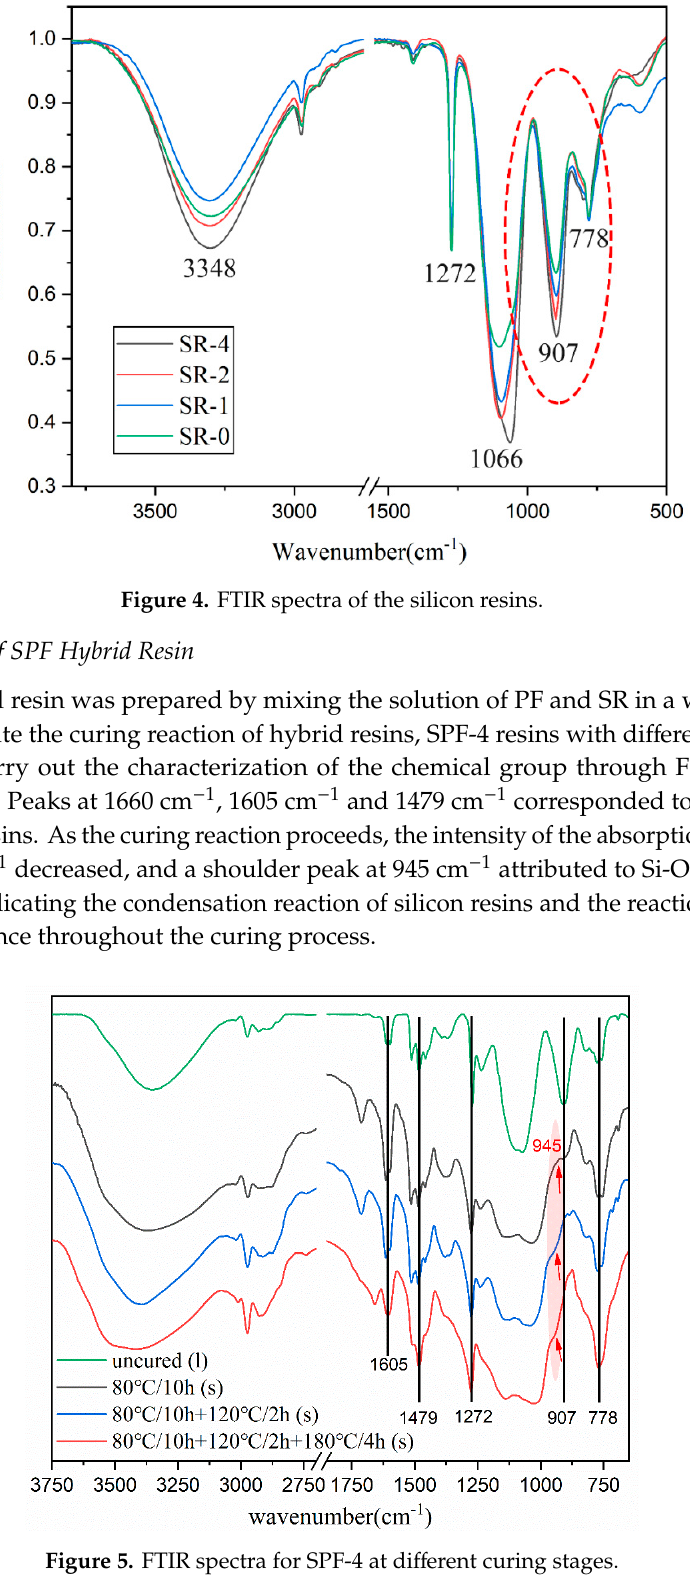
Figure 6. FD ‐ MS spectra of the SPF ‐ 4 hybrid resins cured at 80 °C for 2 h and the corresponding chemical structure.